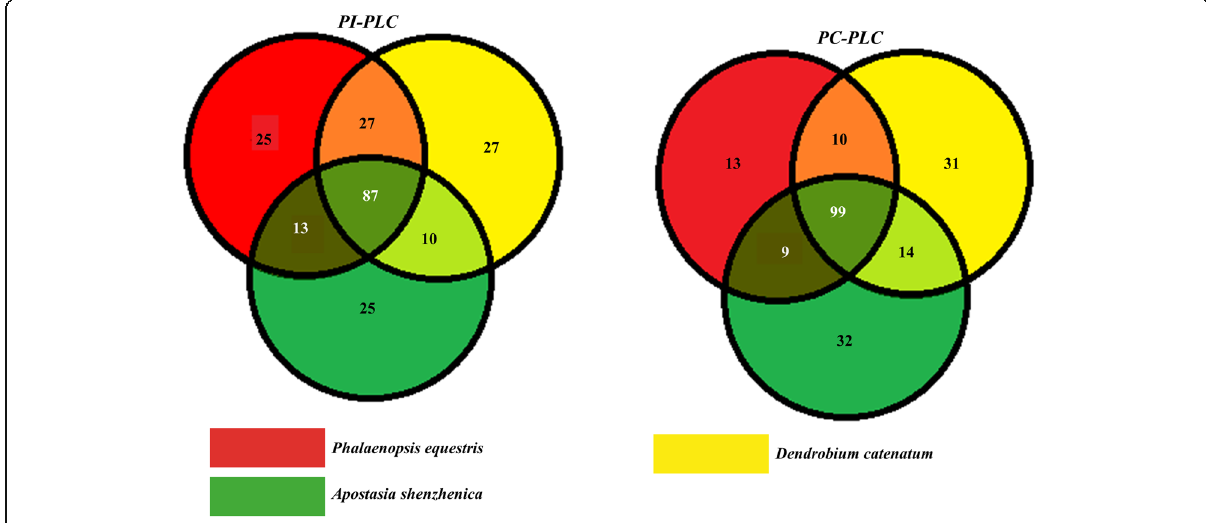
Fig. 5 Promoter analysis: Venn diagram showing common numbers of promoters in PI-PLC ( a ) and PC-PLC ( b )